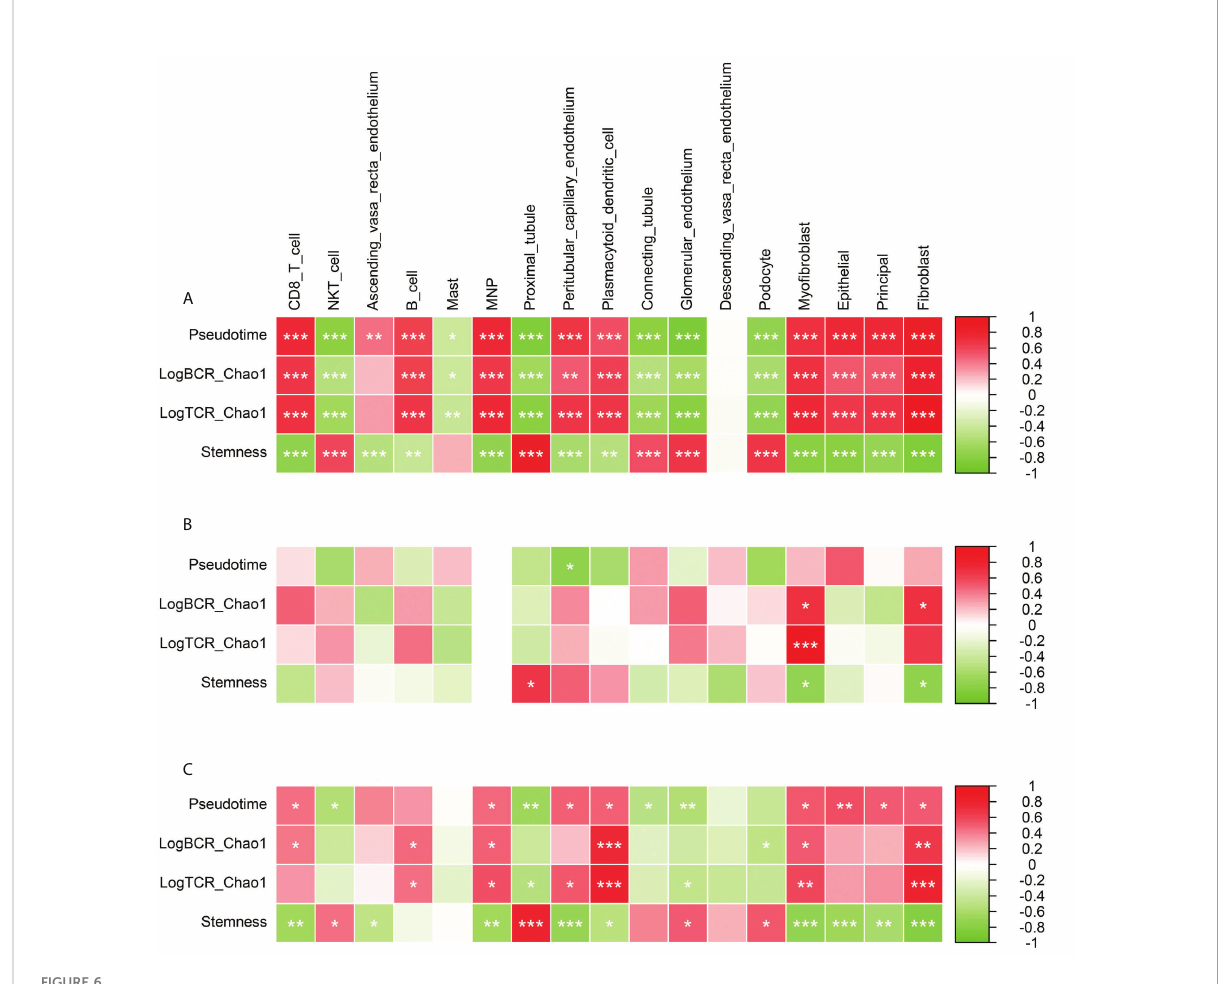
FIGURE 6 Correlation analysis of Pseudotime, LogBCR_Chao1, LogTCR_Chao1, Stemness and various cellular components in tissue microenvironment. (A) Correlation analysis of the scores of 17 types of cells and Pseudo time, LogBCR_Chao1, LogTCR_Chao1, Stemness during the occurrence and development of DN. (B) Correlation analysis of 17 cell scores and Pseudotime, LogBCR_Chao1, LogTCR_Chao1, Stemness during the early occurrence of DN. (C) Correlation analysis of 17 cell scores and Pseudotime, LogBCR_Chao1, LogTCR_Chao1, Stemness during the progression of DN. Spearman correlation analysis for correlation comparison. ***P < 0.001, **P < 0.01, *P <